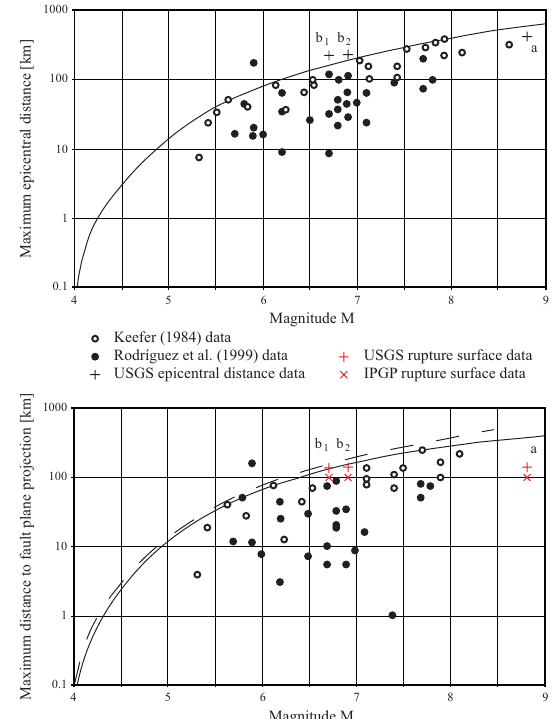
Fig. 2. Upper graph: maximum epicentral distance to disrupted landslides as a function of magnitude M . Bottom graph: maxi- mum fault distance to disrupted landslides as a function of magni- tude M . The magnitude used is the moment magnitude M w , ex- cept for Keefer (1984) data ( M w , surface-wave magnitude M s and Richter local magnitude M L ) . White points: data 1811–1980 from Keefer (1984). Black points: data 1980–1997 from Rodr´ıguez et al. (1999). Solid line: upper bound proposed by Keefer (1984) in case of maximal epicentral distance (upper graph) or maxi- mal fault distance (bottom graph). Dashed line: upper bound of Keefer (1984) for maximal epicentral distance, wrongly reported for maximal distance to fault by Rodriguez et al. (1999). a: 27 February earthquake; b 1 and b 2 : 11 March aftershocks. Modified after Rodr´ıguez et al. (1999) and Keefer